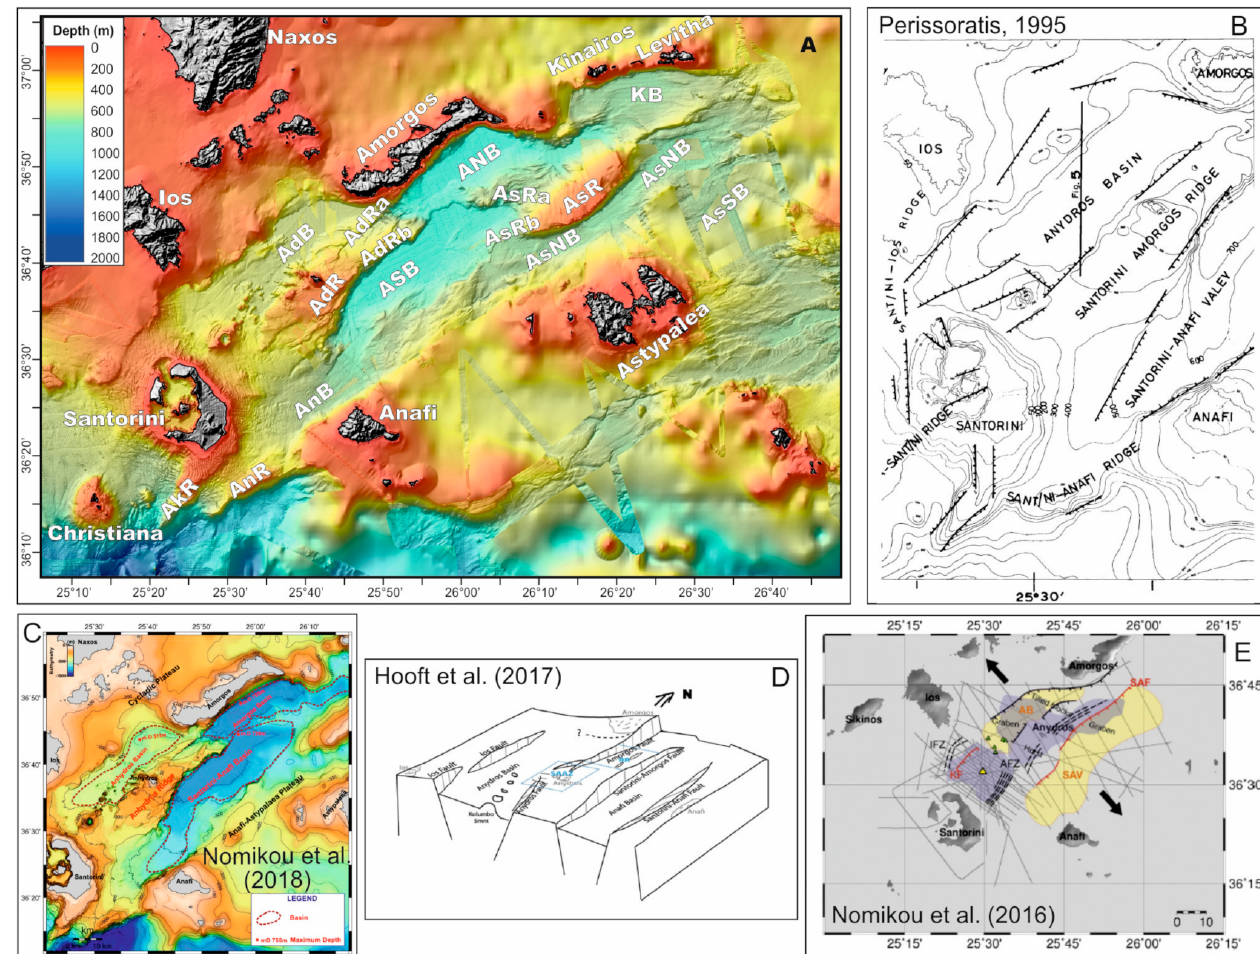
Figure 2. ( A ): Terminology of the main geomorphological elements used and discussed in the current work. AdB: Anydros Basin, AdR: Anydros Ridge, AnB: Anafi Basin, ANB: Amorgos North Basin, ASB: Amorgos South Basin, AsNB: Astypalea North Basin, AsSB: Astypalea South Basin, AsR: Astypalea Ridge, KB: Kinairos Basin. Bathymetry: 25 m resolution swath bathymetry superimposed on 100 m resolution EMODNET Bathymetry. ( B – E ): Terminology used by Perissoratis (1995), Nomikou et al. [54], (Hooft et al. 2017), and (Nomikou et al. 2016),